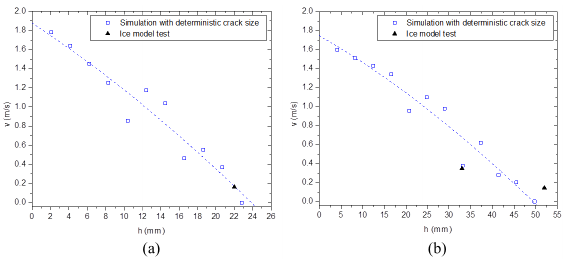
Figure 12: (a) h − ν curve obtained when the vessel is running ahead. (b) h − ν curve obtained when the vessel is running astern. All num- bers are at model scale, and simulations are conducted with deterministic crack size.